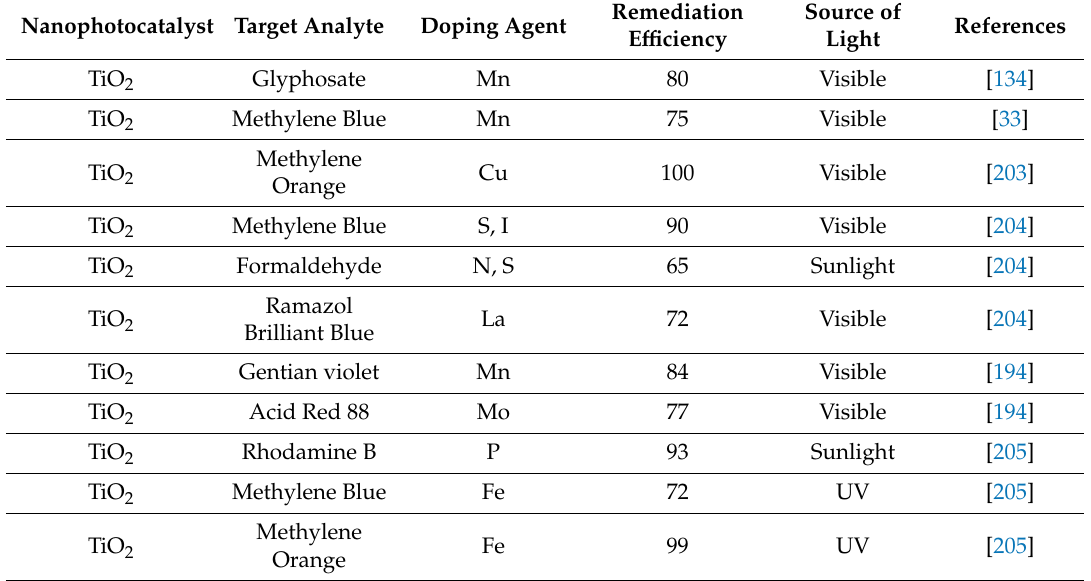
Table 9. Observation of di ff erent pollutant removal by Doped-TiO 2 nanophotocatalyst. Nanophotocatalyst Target